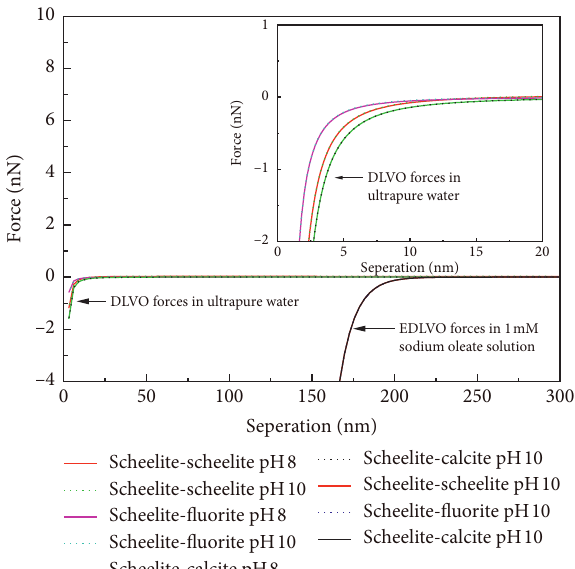
Figure 12: DLVO and EDLVO forces on scheelite-scheelite, scheelite-fluorite, and scheelite-calcite (in pure water of pH 8 or 10, c − 1 � 960nm [18], and R � 5 ∗ 10 − 9 m; in 1mM sodium oleate solution of pH 10, c − 1 � 9.6nm [18], and K